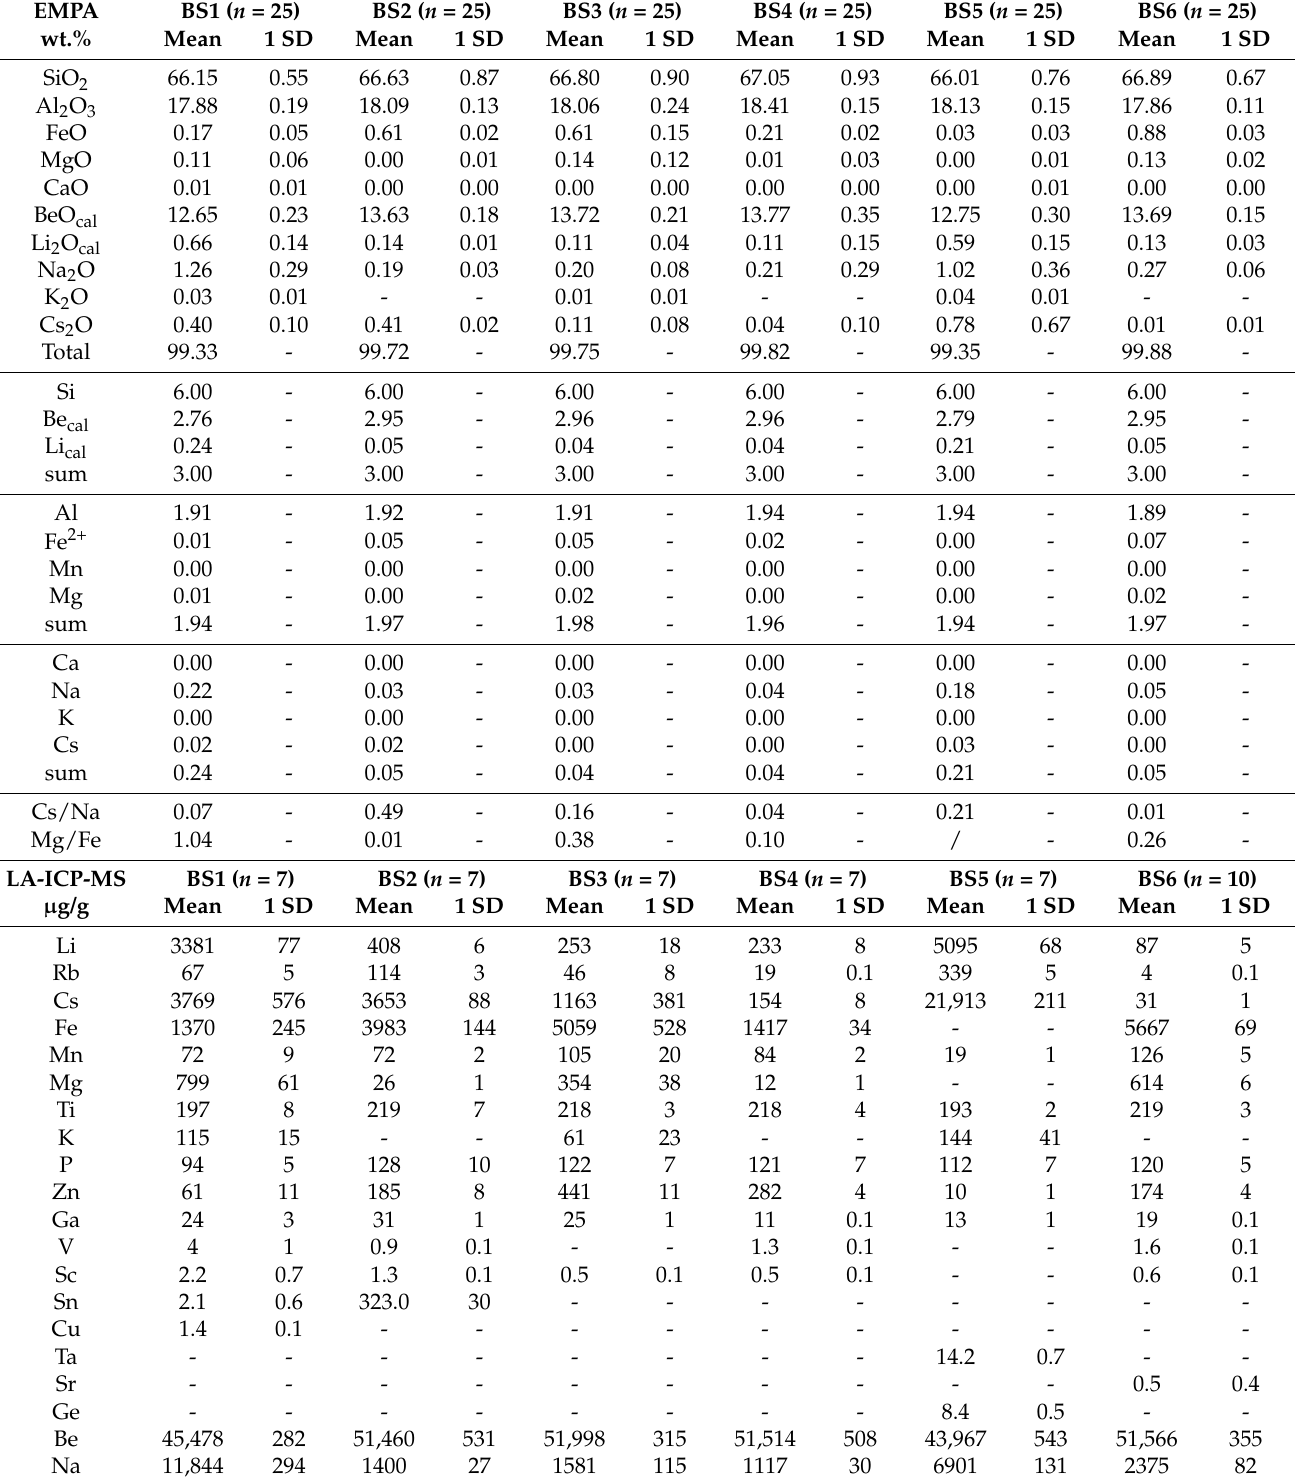
Table 2. Quantitative element contents using EMPA and LA-ICP-MS for the beryl crystals used in this